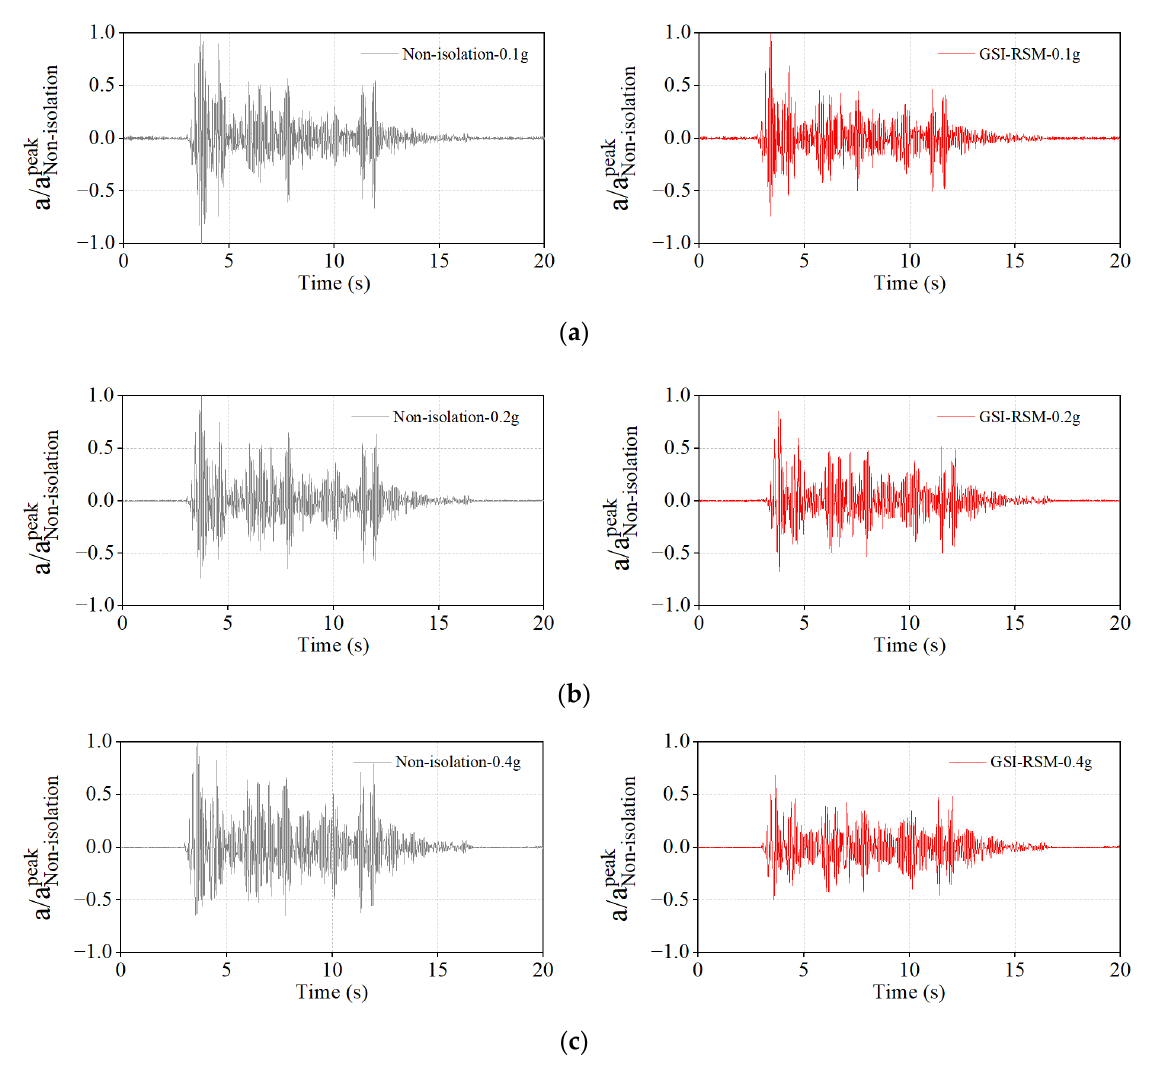
Figure 18. Normalized acceleration time–history curve of structural roof: ( a ) input acceleration amplitude of 0.1 g; ( b ) input acceleration amplitude of 0.2 g; ( c ) input acceleration amplitude of 0.4 g.